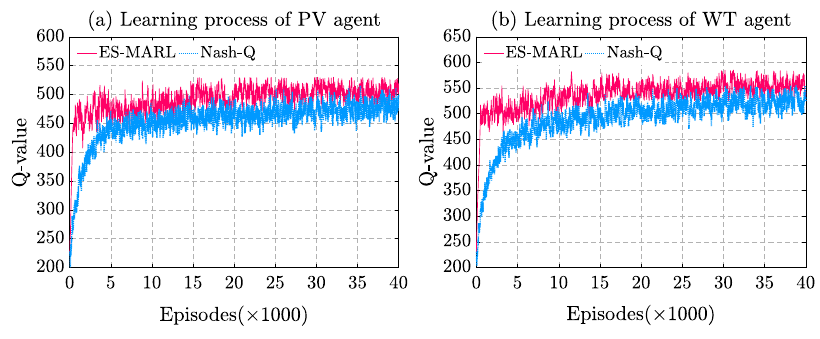
Figure 12. MARL learning process of PV agent and WT agent.